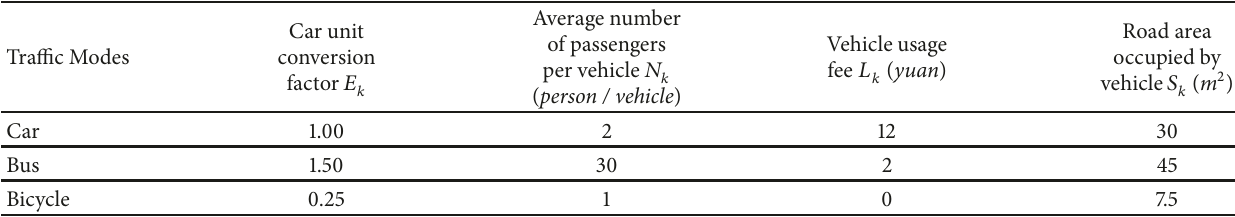
Table 3: Relevant data of different traffic